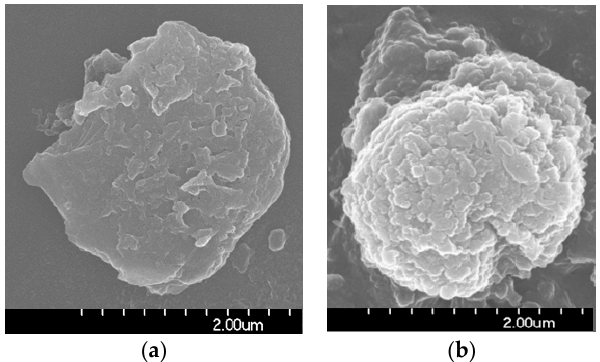
Figure 2. Scanning electron microscopy (SEM) images. ( a ) hexadecylamine ‐ modified polyaspartic acid (HPASP); ( b ) two enzymes immobilized on HPASP (SOD ‐ ELP/CAT ‐ ELP@HPASP).